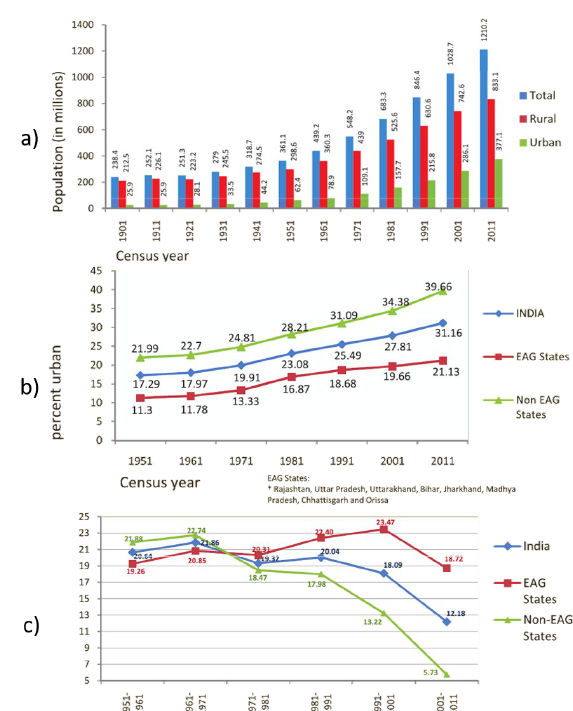
Figure 2. a) Total Population by Residence b) Percentage of Urban Population c) Rural Growth Rates in India (Census of India,